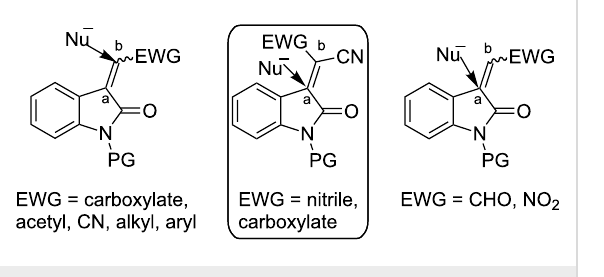
Figure 1: Oxindole based Michael